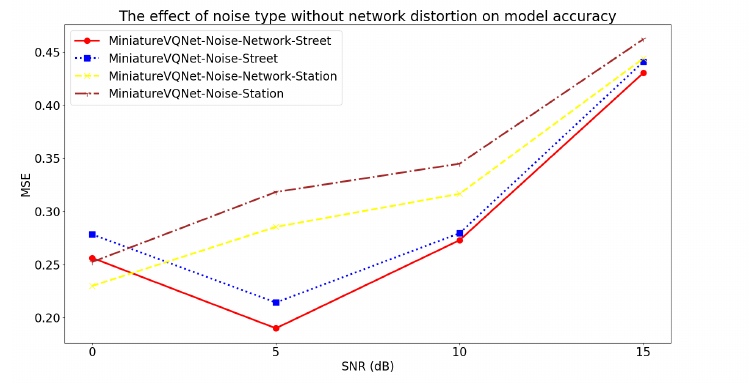
Figure 6. Effect of noise type on prediction accuracy.